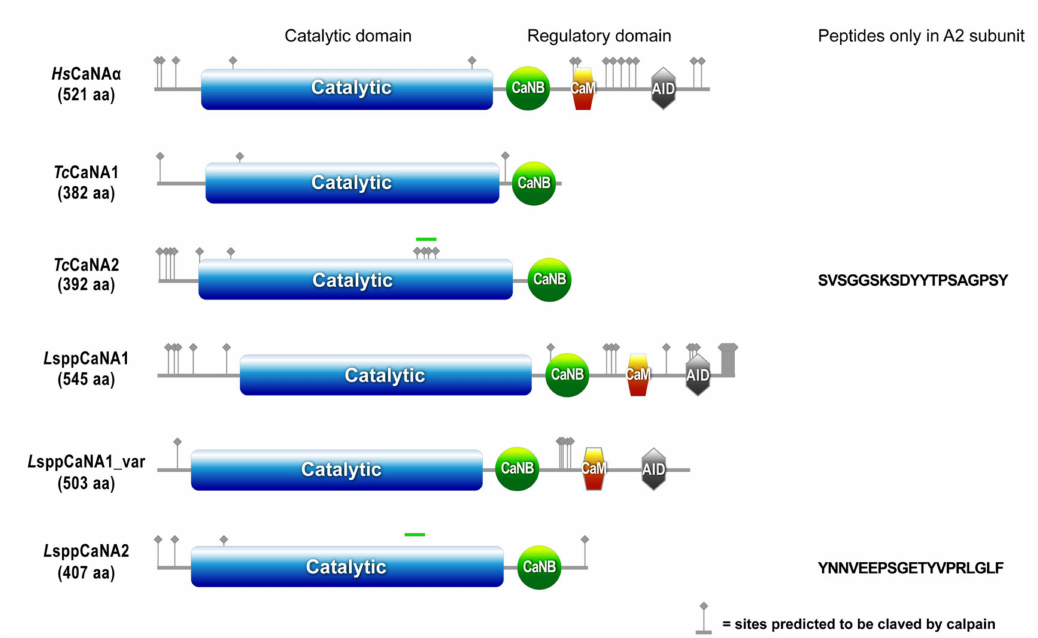
Figure 1. Protein domain architecture in CaNA. In blue is the catalytic phosphatase domain, in green is the CaNB-binding domain, in orange is the domain of interaction with CaM, and in gray is the AID. They are represented by the sites predicted to be cleaved by calpain by GPS-CDD, and the green band on the catalytic domains of Tc CaNA2 and L sppCaNA2 corresponds to a peptide not present in the CaNA1 subunits, specified to the right of each subunit. The image was prepared with the MyDomains image creator (Prosite).